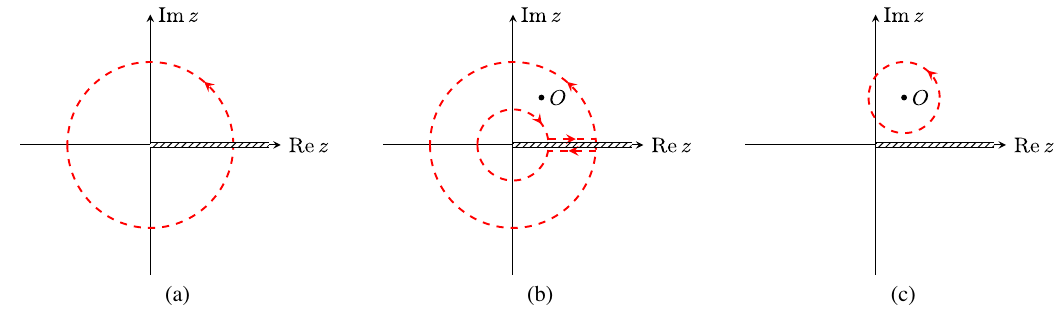
FIG. 2. (a) Integral contour for H 0 and H 1 on the z coordinate. (b) Dashed circles are the integral contour for the commutator ½ H 0 ; O (cid:2) , ½ H 1 ; O (cid:2) ; red horizontal lines are attached to circles to make it close. (c) The deformed